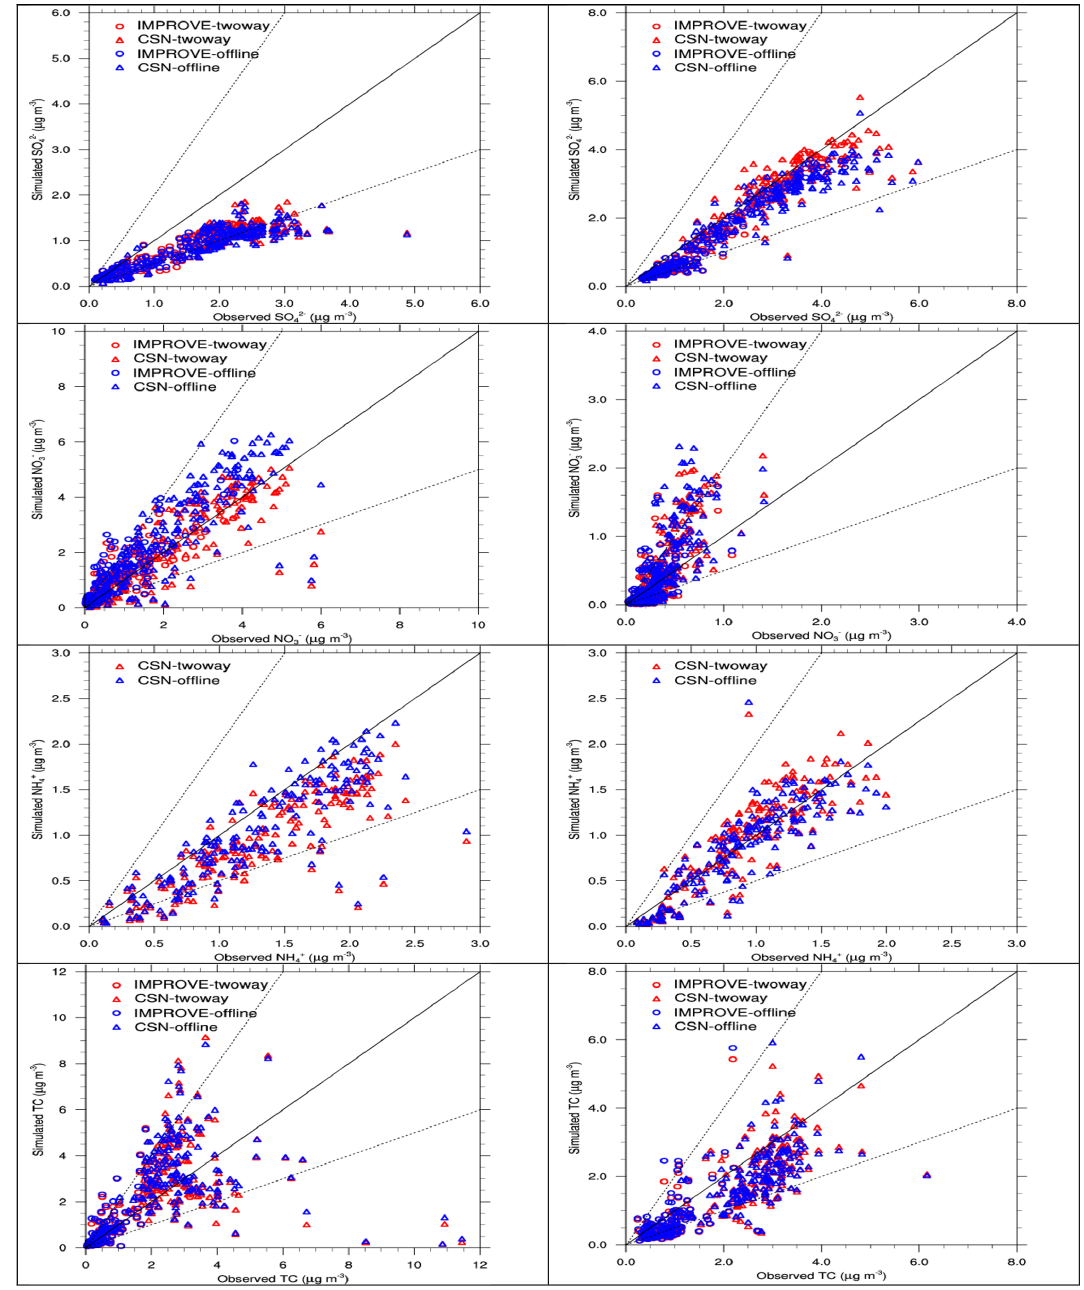
Figure 11. Scatterplots of 5-year averaged PM 2 . 5 constituents for SO 2 − simulations of two-way WRF-CMAQ (red color) and offline CMAQ (blue) in winter (left column) and summer (right column)